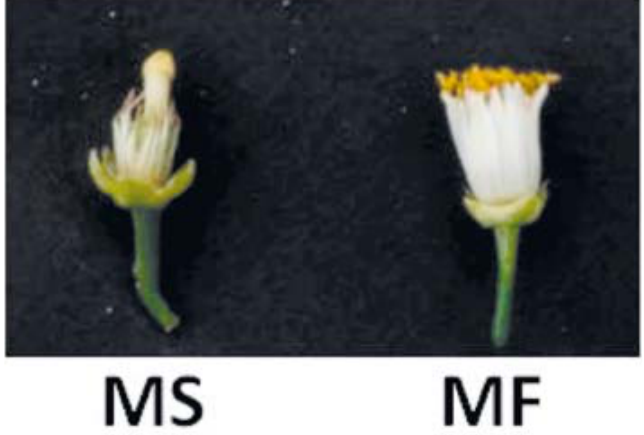
Fig. 1 - Flowers of male-sterile (aborted anthers, MS) and male-fertile (normal anthers, MF)